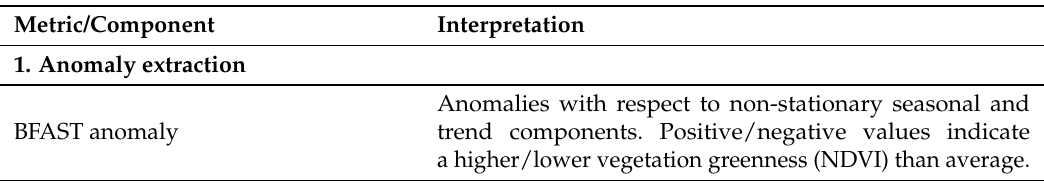
Table 1. Overview of the methodology and interpretation of the used metrics/time series components. BFAST, Breaks For Additive Season and